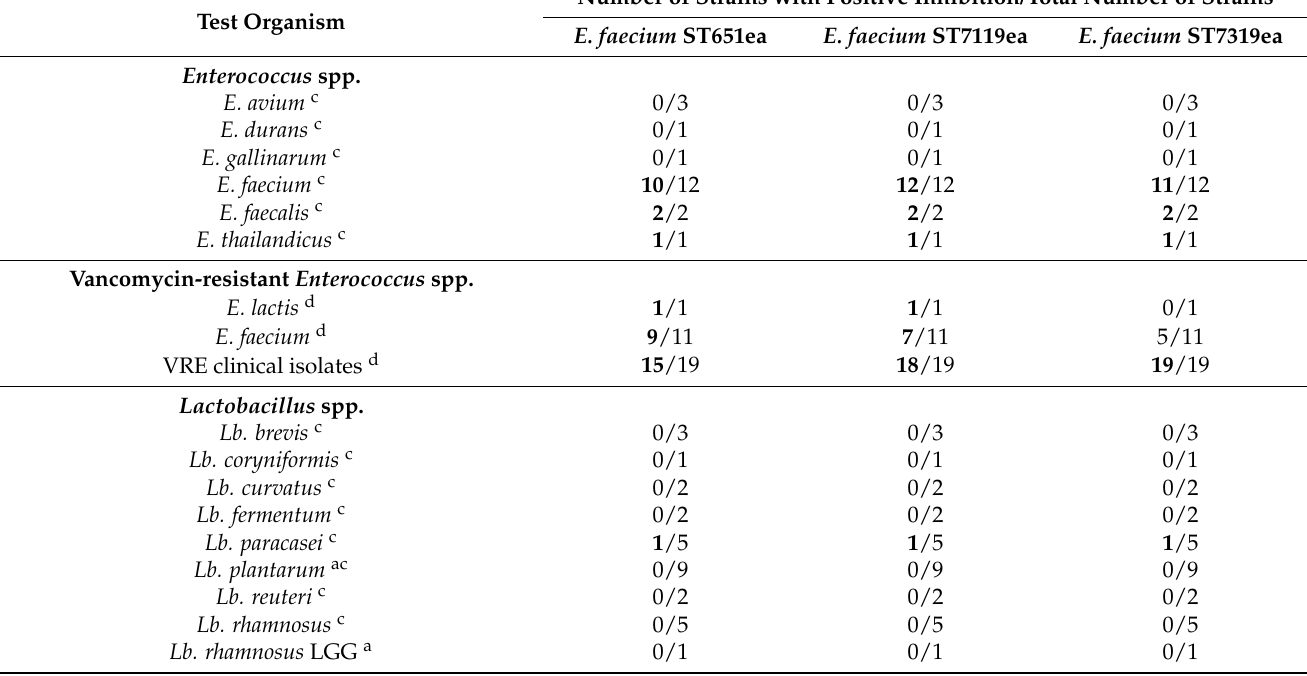
Table 3. The spectrum of antibacterial activity of bacteriocins produced by strains E. faecium ST651ea, ST7119ea and